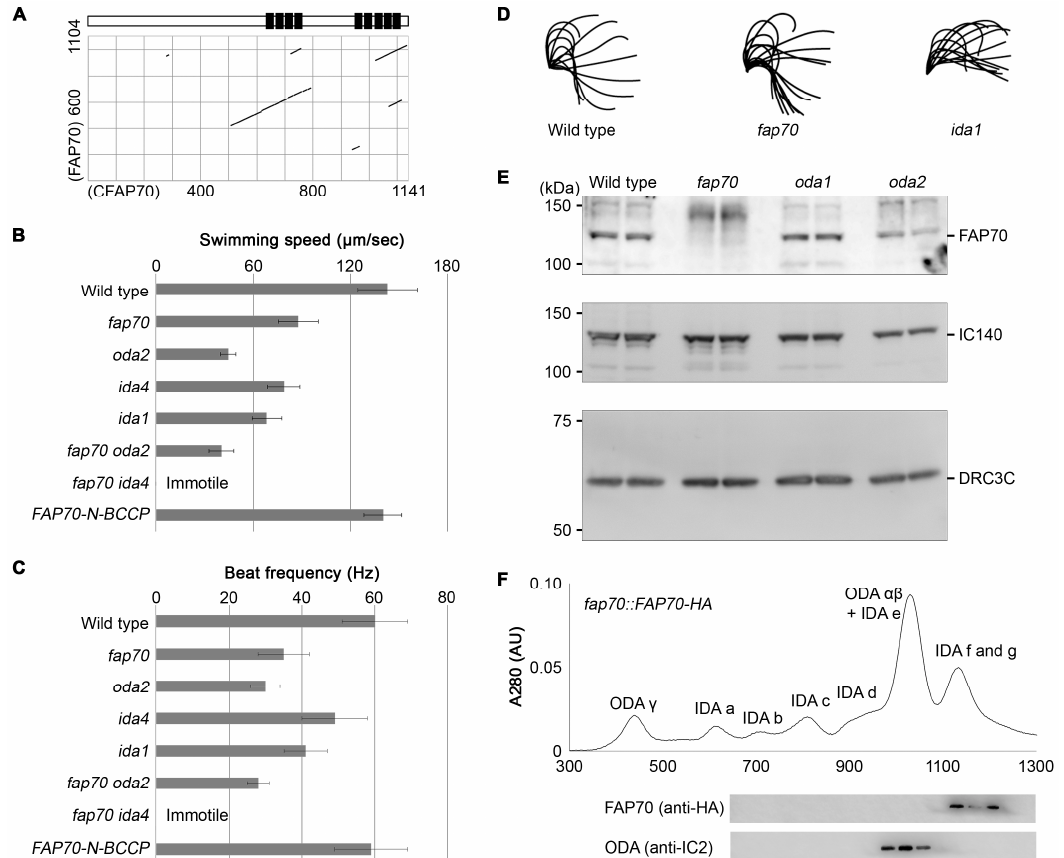
Figure 5. Characterization of a Chlamydomonas reinhardtii mutant lacking FAP70. ( A ) Analysis of the sequence similarity between mouse CFAP70 and Chlamydomonas FAP70 proteins. The dot plot was generated by a BLASTP program [46,47], where CFAP70 (1141 amino acids) is represented on the X-axis and FAP70 (1104 amino acids) is represented on the Y-axis. Matched sequence alignments are shown as lines. Shown on the top of the plot is the CFAP70 schematic diagram shown in Figure 3A. ( B , C ) The swimming speed ( B ) and flagellar beat frequency ( C ) of Chlamydomonas. Wild-type, three single mutants ( fap70 , oda2 , ida4 , and ida1 ), two double mutants ( fap70 oda2 and fap70 ida4 ), and the fap70 mutant expressing FAP70-N-BCCP ( FAP70-N-BCCP ) were analyzed. Data are presented as the mean ± SD ( n = 20). ( D ) Representative tracings of the flagellar beating form. ( E ) Western blot analysis of FAP70, IC140 (inner dynein arm), and DRC3C (dynein regulatory complex) protein levels in wild-type and three different mutants ( fap70 , oda1 , and oda2 ). Twenty micrograms of axonemal protein lysate were loaded on each lane. To the left of the gel, the positions and sizes (kDa) of molecular weight standards are indicated. ( F ) Top, a 0.6 M KCl extract from fap70::FAP70-N-BCCP-HA axonemes was separated by MonoQ anion-exchange chromatography column. The protein peaks of known dynein arm complexes are labeled. Bottom, the MonoQ fractions were separated by SDS-PAGE and FAP70 and outer dynein arms (ODAs) were detected using anti-HA and anti-IC2 antibodies, respectively.